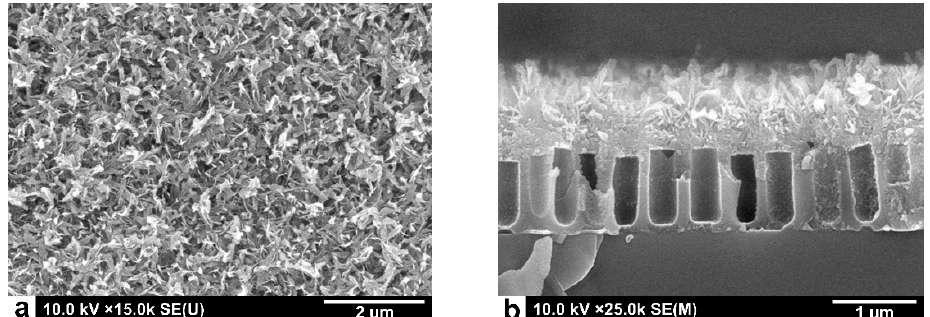
Figure 5. SEM images of the Sn x Bi k Mo y O z gas sensitive layer deposited on the anodized alumina matrix, ( a ) front view and ( b ) profile view.